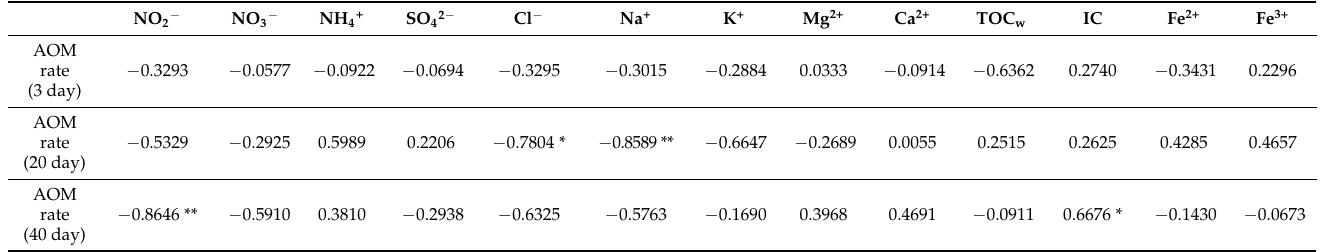
Table 4. Pearson correlations ( r ) between AOM rate and pore-water